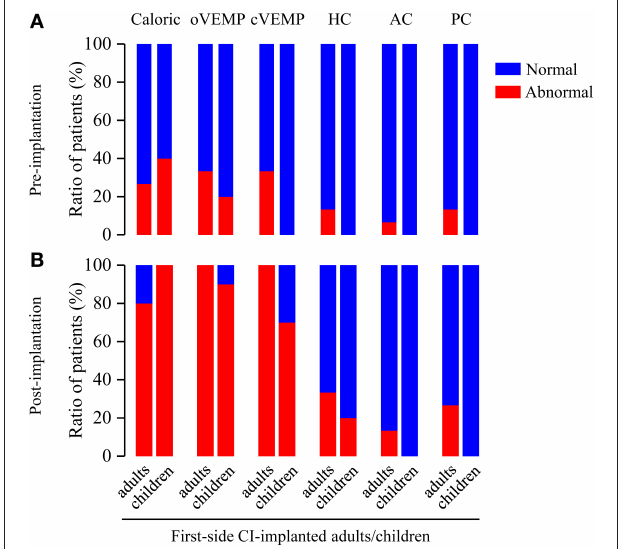
FIGURE 2 | Ratio of patients with abnormal vestibular functions revealed by pre- and post-implantation caloric test, VEMP test, and vHIT in first-side CI-implanted adults and children. (A) Pre- and (B) post-implantation tests showed no significant difference of abnormal rates between first-side CI-implanted adults and children.